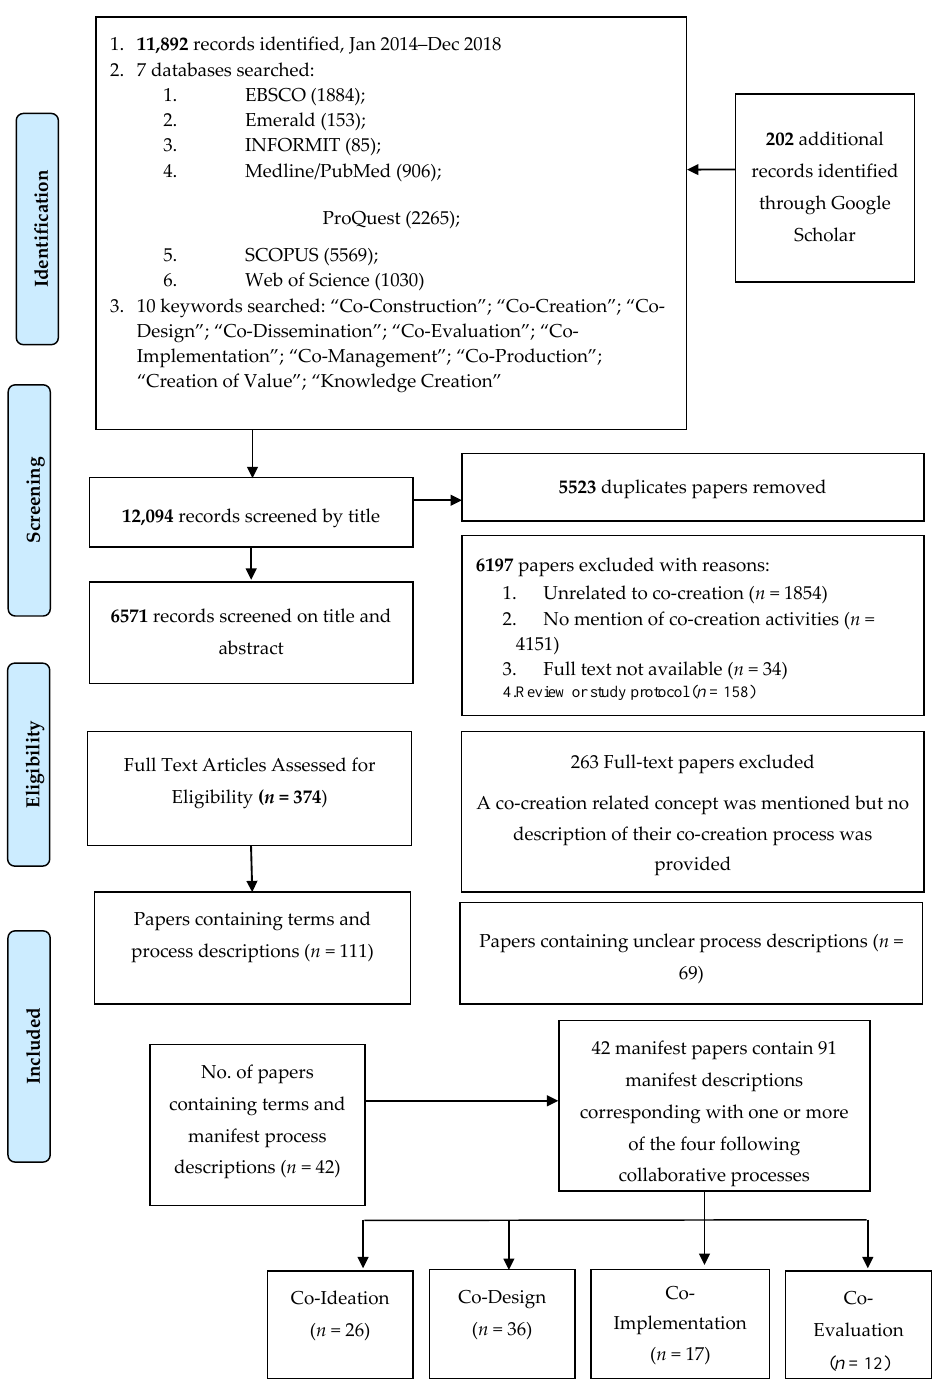
Figure 1. Preferred Reporting Items for Systematic Reviews and Meta-Analyses